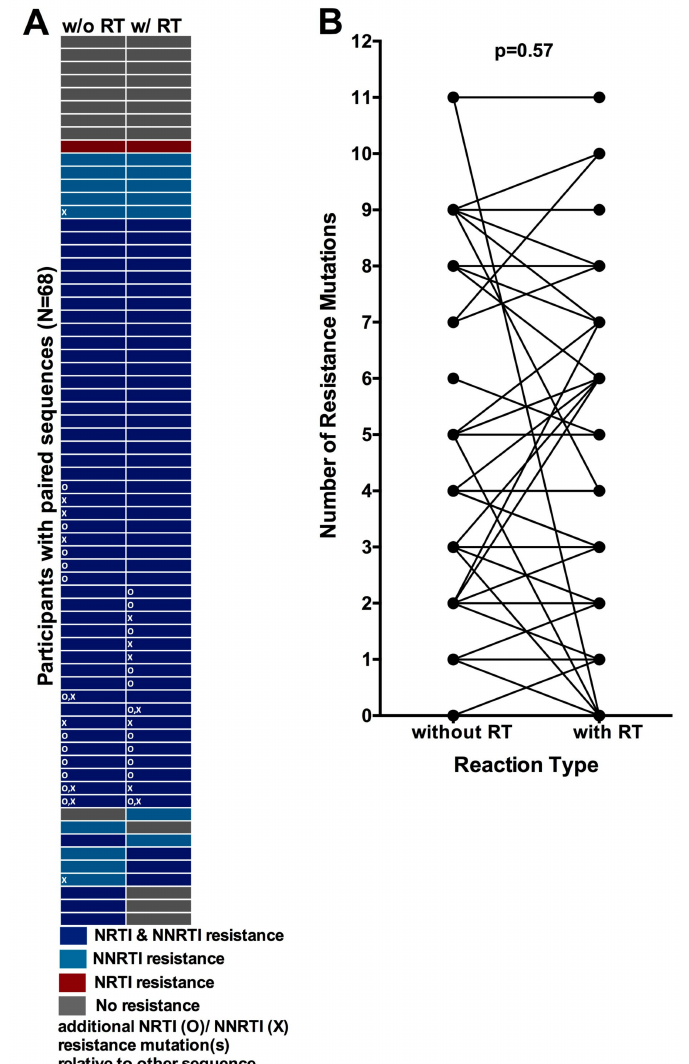
Figure 4. Concordance between resistance genotypes amplified with and without an initial Reverse Transcriptase (RT) step: ( A ) Resistance genotype concordance for 68 participants for whom paired PCR and RT-PCR genotypes were available (one participant per row). Color denotes resistance at the level of drug class. “O” symbols indicate that the genotype harbors at least one NRTI resistance mutation that is not observed in its associated pair, while “X” symbols indicate that the genotype harbors at least one NNRTI resistance mutation that is not observed in its associated pair; ( B ) Total number of resistance mutations observed in genotypes obtained with (right) and without (left) an initial RT step, where connecting lines indicate linked